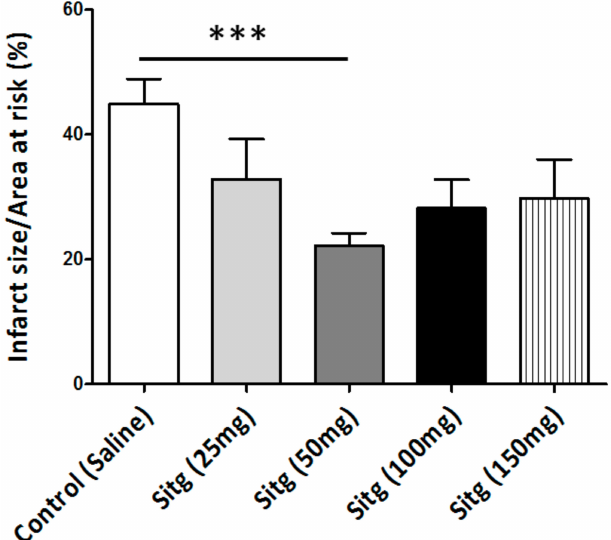
Figure 2. Effect of different doses of Sitagliptin (Sitg) on infarct size (expressed in %). Results are shown as (Mean ± Standard error of mean (SEM)); ( n = 8–16 animals/group). Statistical significance: *** p < 0.001 relative to the Control group. Sitg (50 mg) exhibited a cardioprotective effect against ischemia-reperfusion (I/R) injury, while no significance was reported in other doses (25, 100, and 150